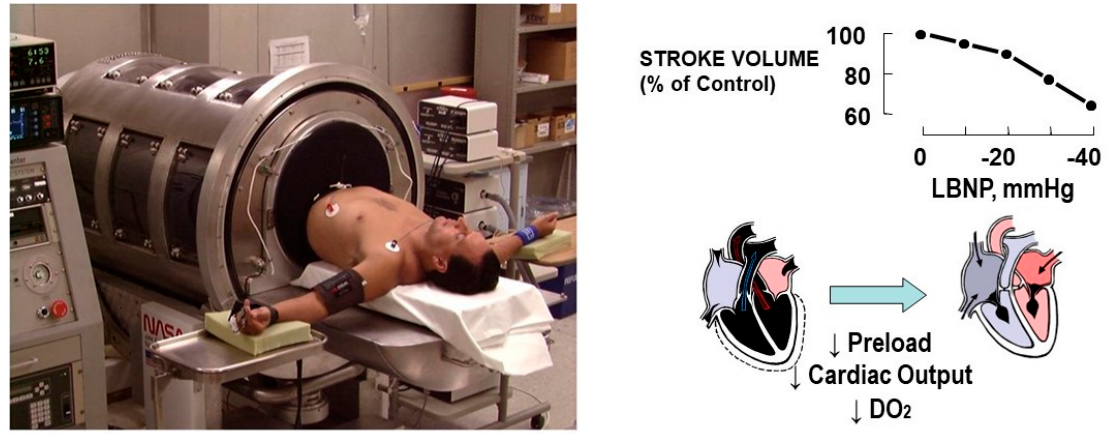
Figure 1. Human subject placed in the lower body negative pressure (LBNP) chamber used to induce progressive reductions in cardiac filling (preload), stroke volume, cardiac output and DO 2 similar to hemorrhage.